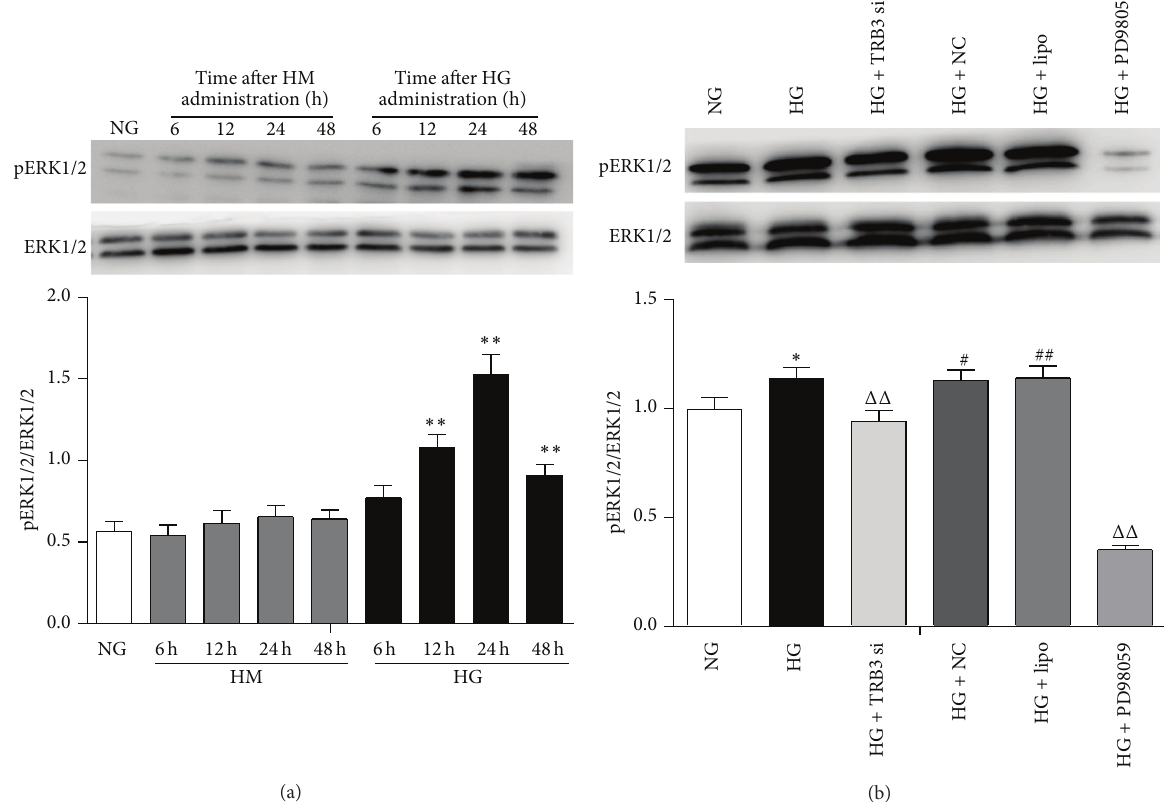
Figure5:EffectofTRB3onphosphorylatedERK1/2(pERK1/2)expressionincells.(a)WesternblotanalysisofpERK1/2levelincellsincubated with HM or HG for 6, 12, 24, and 48h. (b) Cells were transfected with TRB3 siRNA or corresponding negative control. Western blot analysis of pERK1/2 level with HG stimulation for 48 h. Data are mean ± SEM. ∗ 𝑃 < 0.05 , ∗∗ 𝑃 < 0.01 versus NG, ΔΔ 𝑃 < 0.01 versus HG, and # 𝑃 < 0.05 , ## 𝑃 < 0.01 versus NG +TRB3